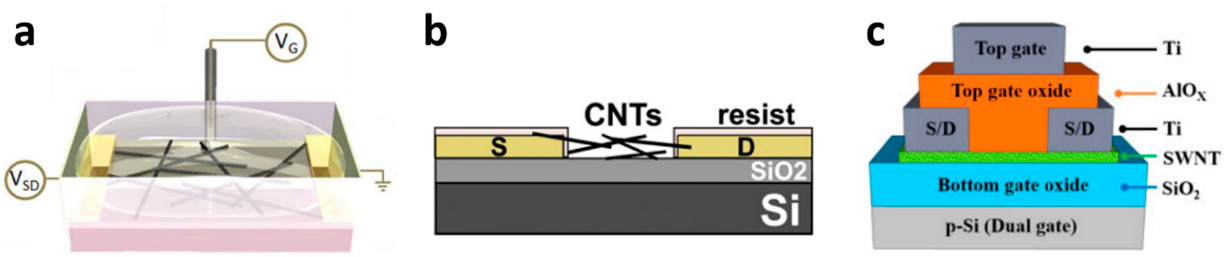
Figure 4. Topology of ( a ) liquid top gate, ( b ) bottom gate and ( c ) extended-dual gate CNT-FET. Reproduced from [54,60,107]. Reprinted with permission. CC BY 3.0.